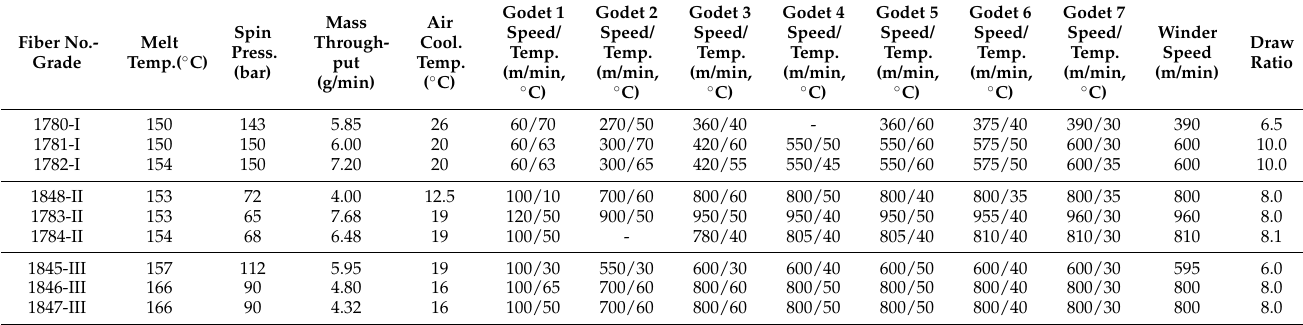
Table 2. Production parameters of PHBH